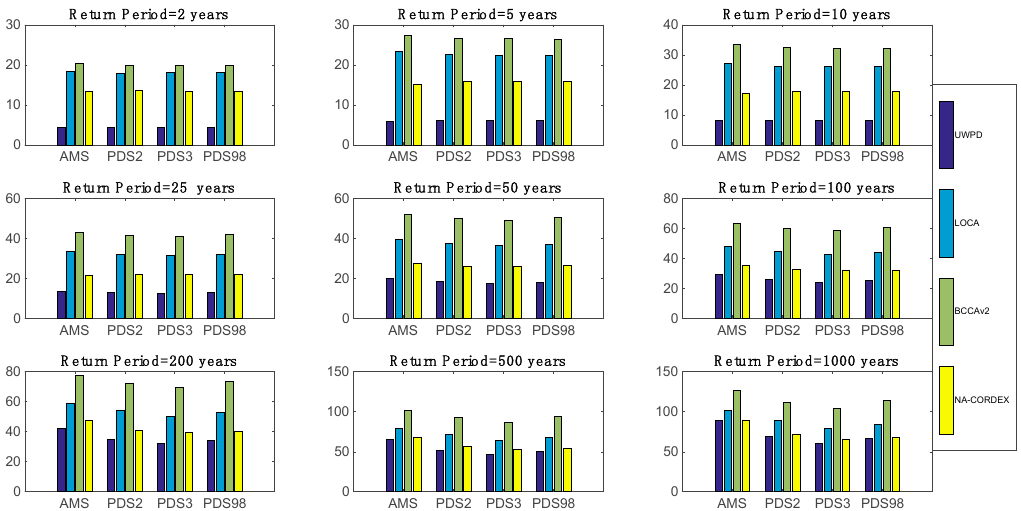
Figure 7. RMSE of PF estimates for downscaled data for different return periods. Similar to Figure 6 but for RMSE.